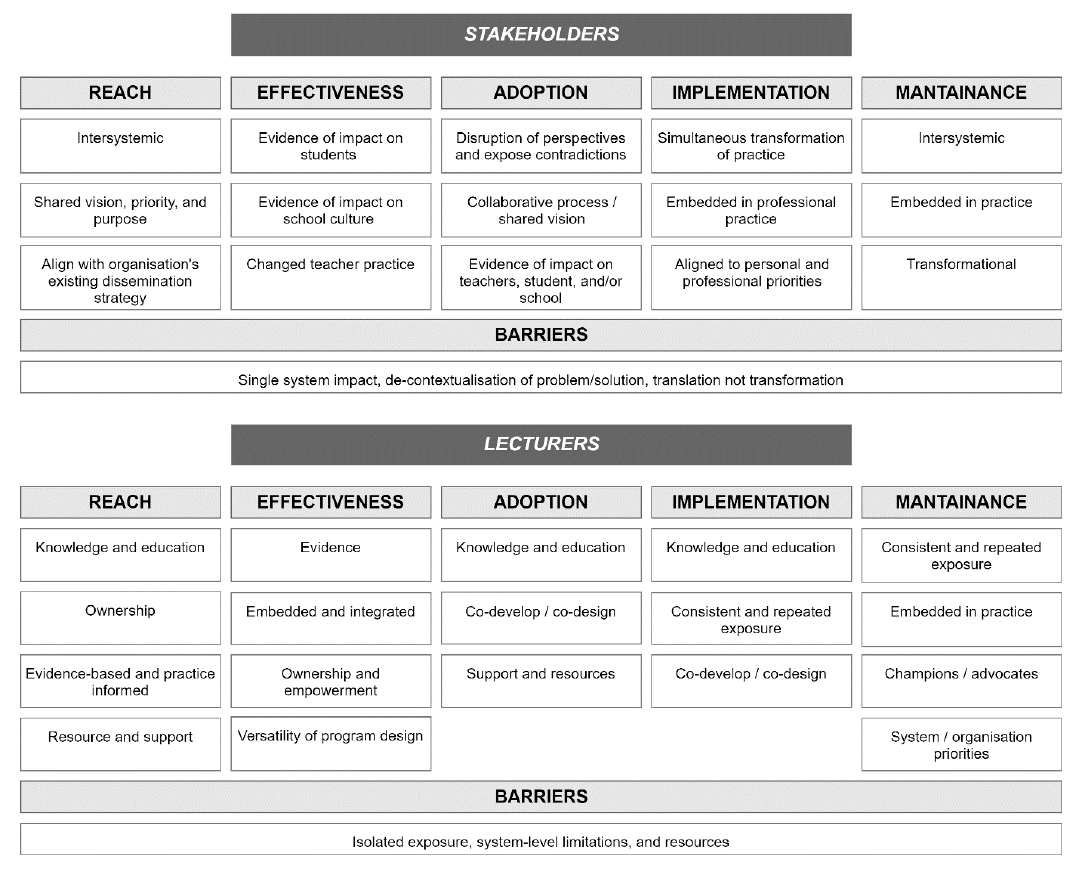
Figure 4. Major themes emerging from stakeholder and lecturer interviews.